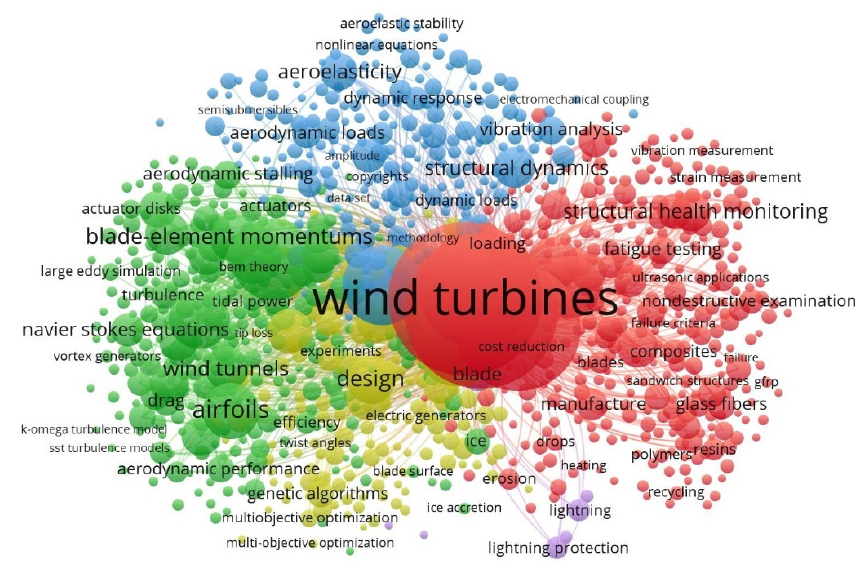
Figure 3. Keyword clusters on optimizing wind turbine efficiency.